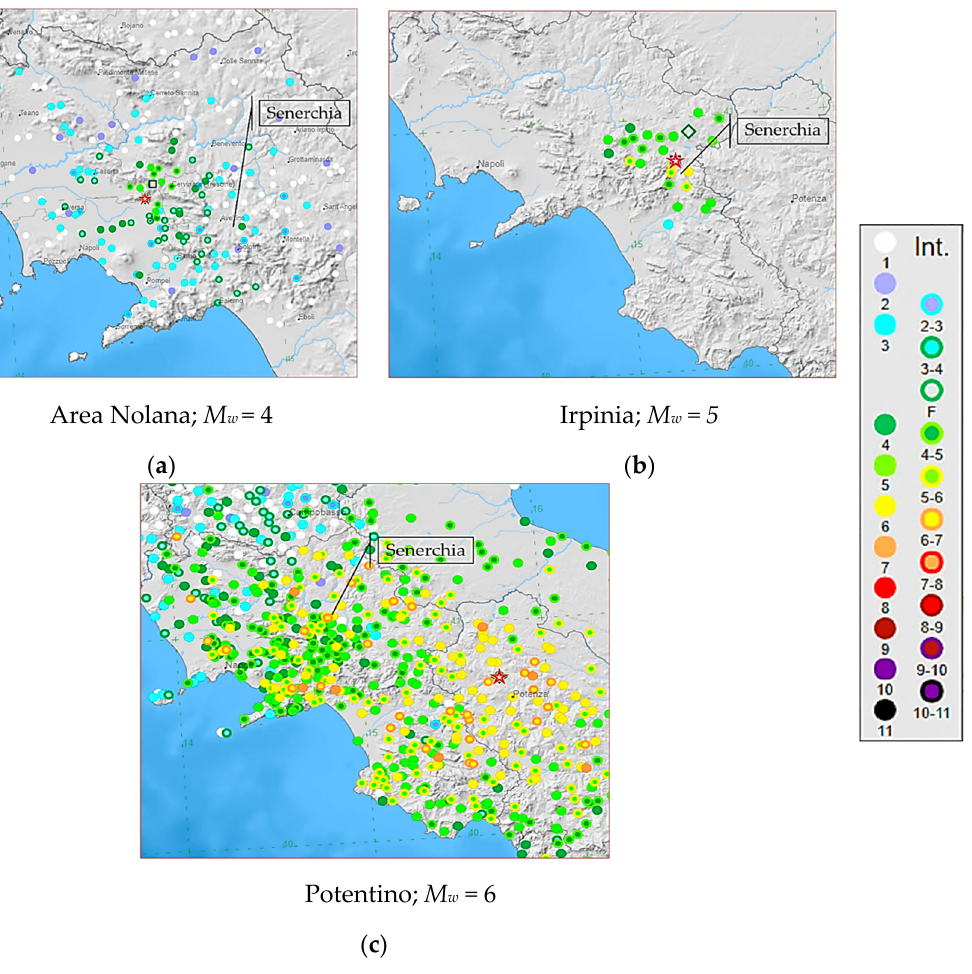
Figure 7. The historical earthquakes selected for the case study area: ( a ) Area Nolana; ( b ) Irpinia; ( c ) Potentino